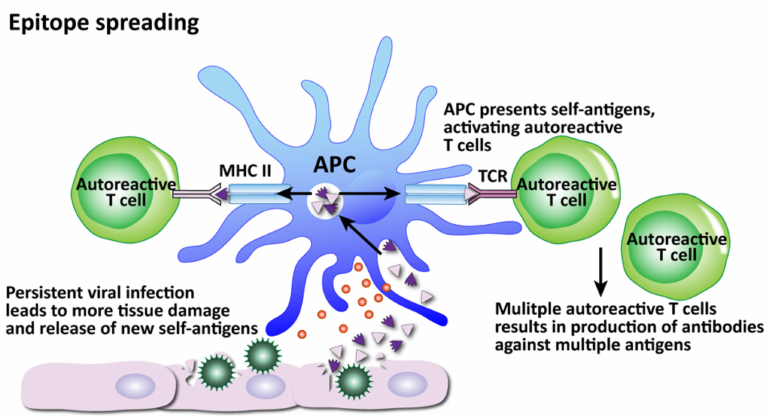
Figure 14. How viruses can induce autoimmunity through epitope spreading. Persistent viral infection and continued tissue damage leads to the release of even more and more new self-antigens, increasing the number of self-tissue targets as the autoreactive T cells spread their attacks to more